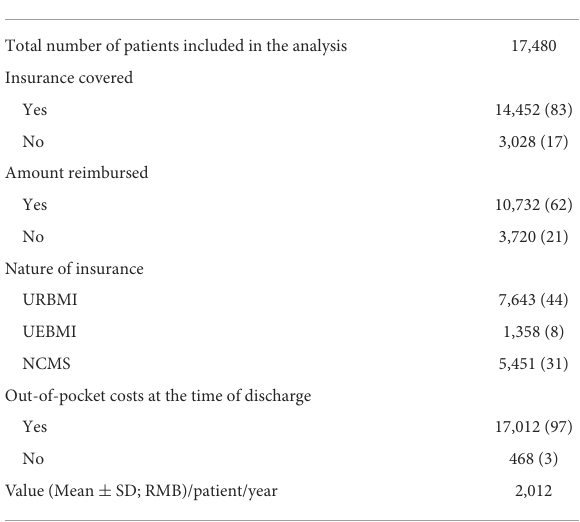
TABLE 8 Mental health inpatient services preference disparities in the utilization according to covered insurance. Parameters used